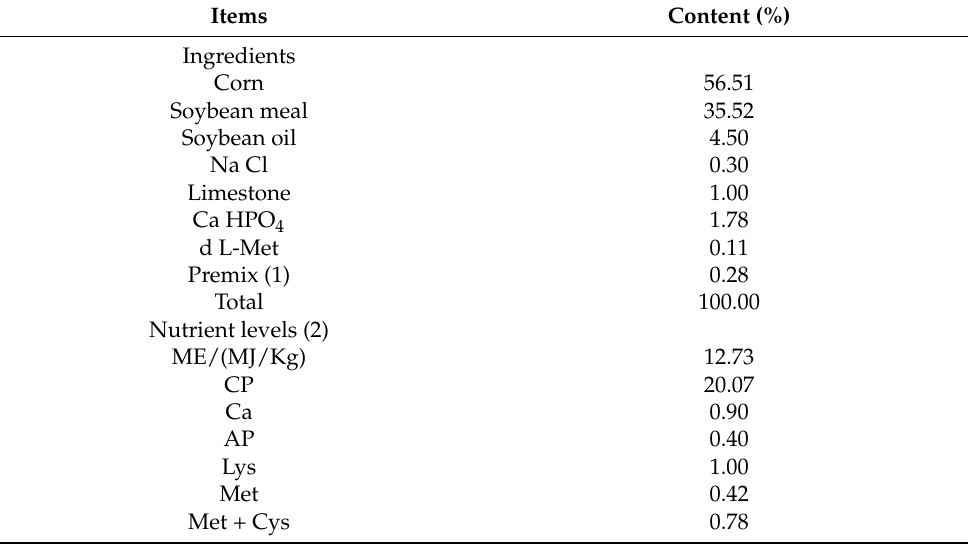
Table 1. Composition and nutrient levels of the basal